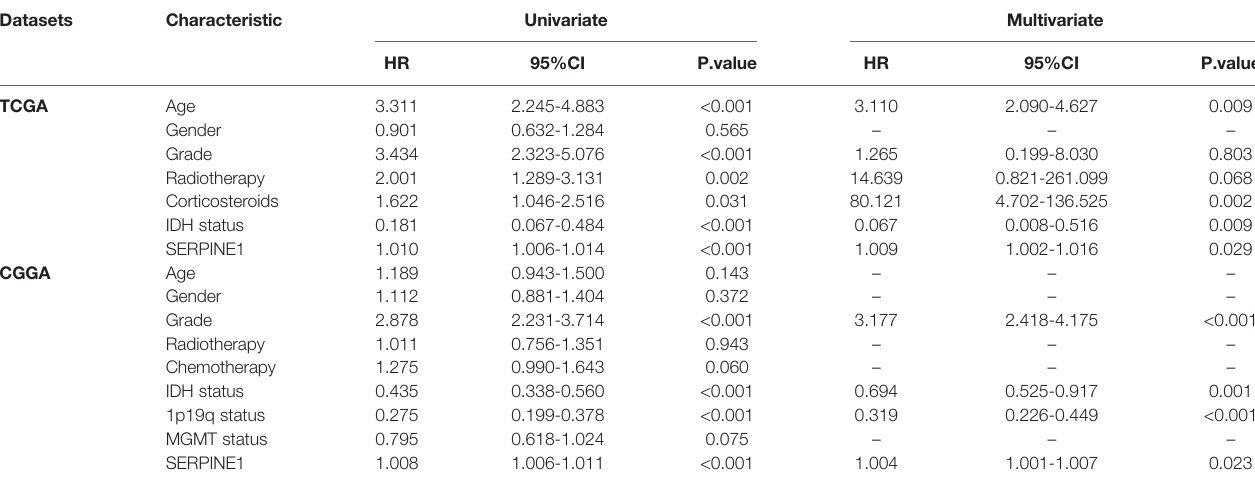
TABLE 2 | Univariate analysis and multivariate analysis of overall survival in the LGG cohort.